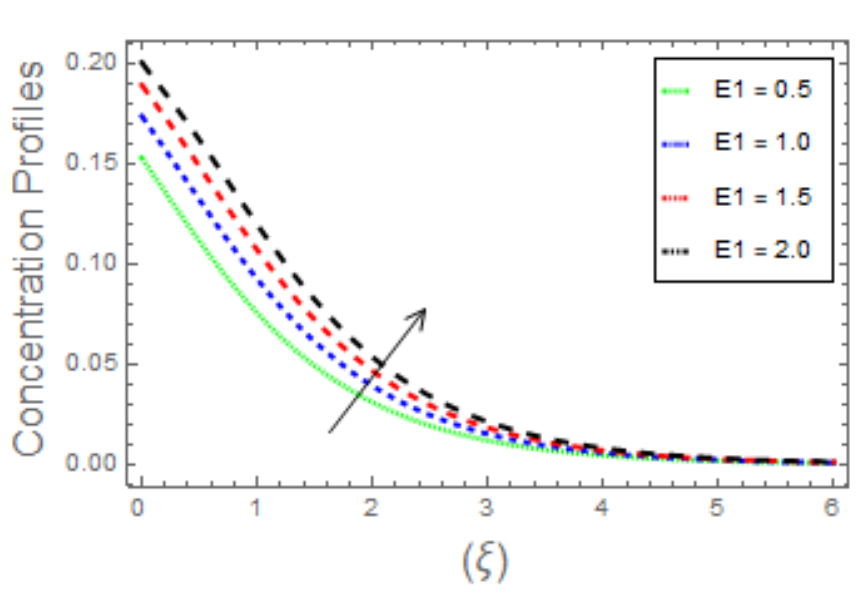
Figure 19. Variation in C due to E 1 . Figure 20 delineates the Sc effect on fluid concentration. Physically, Sc and D are related inversely. Thus, an upsurge in Sc causes a decline in C ( ξ ) curves. From a physical point of view, D declines as Sc increases. Hence, C ( ξ ) diminishes. The concentration profiles of C ( ξ ) for B 2 are unveiled in Figure 21. Clearly, C ( ξ ) is an increasing function of B 2 . The mass transference coefficient h 2 increases once B 2 is improved. Consequently, C ( ξ ) increases. The impact of the drag force coefficient C f x against the different values of M and A is depicted in Figure 22. This figure reveals that C f x is a growing function of both parameters. Attributes of Nb and Nt influences on heat transfer coefficient Nu x are shown in Figure 23. This graph confirms that Nu x diminishes, subject to enlarged Brownian and thermophoresis parameters. Figure 24 designates the effects of Nb and Sc on mass flow coefficient Sh x . As it is observed from this plot, Sh x increases with larger data of these